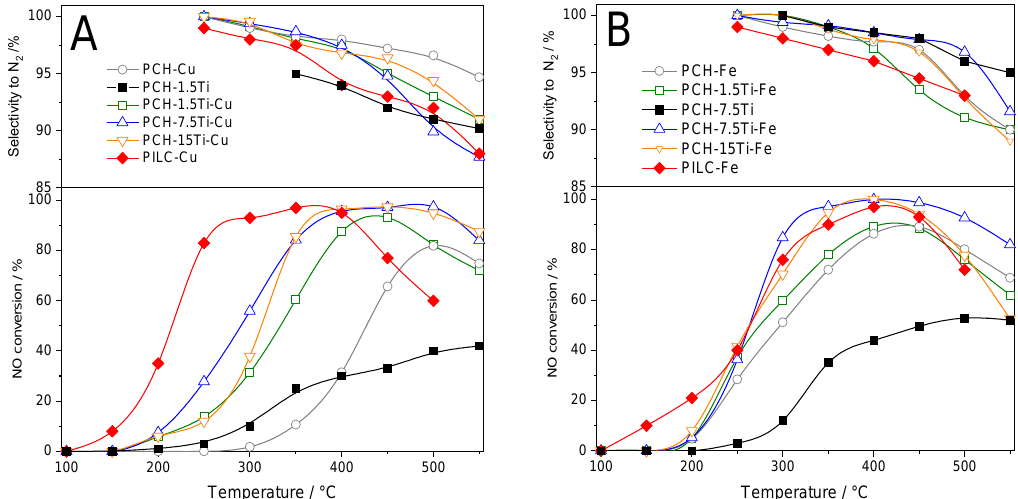
Figure 6. Results of catalytic tests for the PCH samples intercalated with titania–silica pillars (Ti molar contents in pillars were 0, 1.5, 7.5, and 15%) modified with copper ( A ) and iron ( B ). For comparison, results for Ti-PILCs modified with copper and iron are presented. Reaction conditions: 0.1 g catalyst, [NO] = [NH 3 ] = 2500 ppm, [O 2 ] = 2.5%, He = balance, total flow rate = 40 mL min − 1 , and GHSV = 12,500 h − 1 . Based on the results presented in [15] with permission from ref. [43]. Copyright 2009 Elsevier.